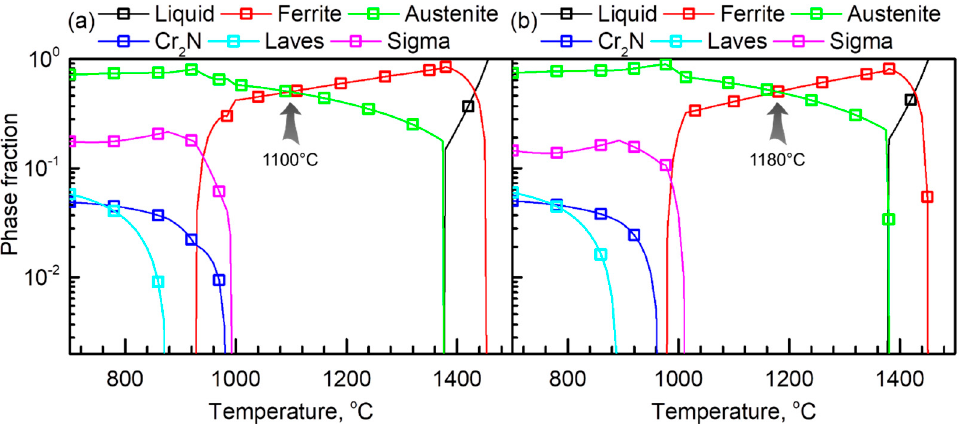
Figure 1. Equilibrium phase fractions of ( a ) Ni03 and ( b ) Ni57 alloys as a function of temperature calculated using Thermo-Calc software (version 2019a, TCFE 9.0 database).